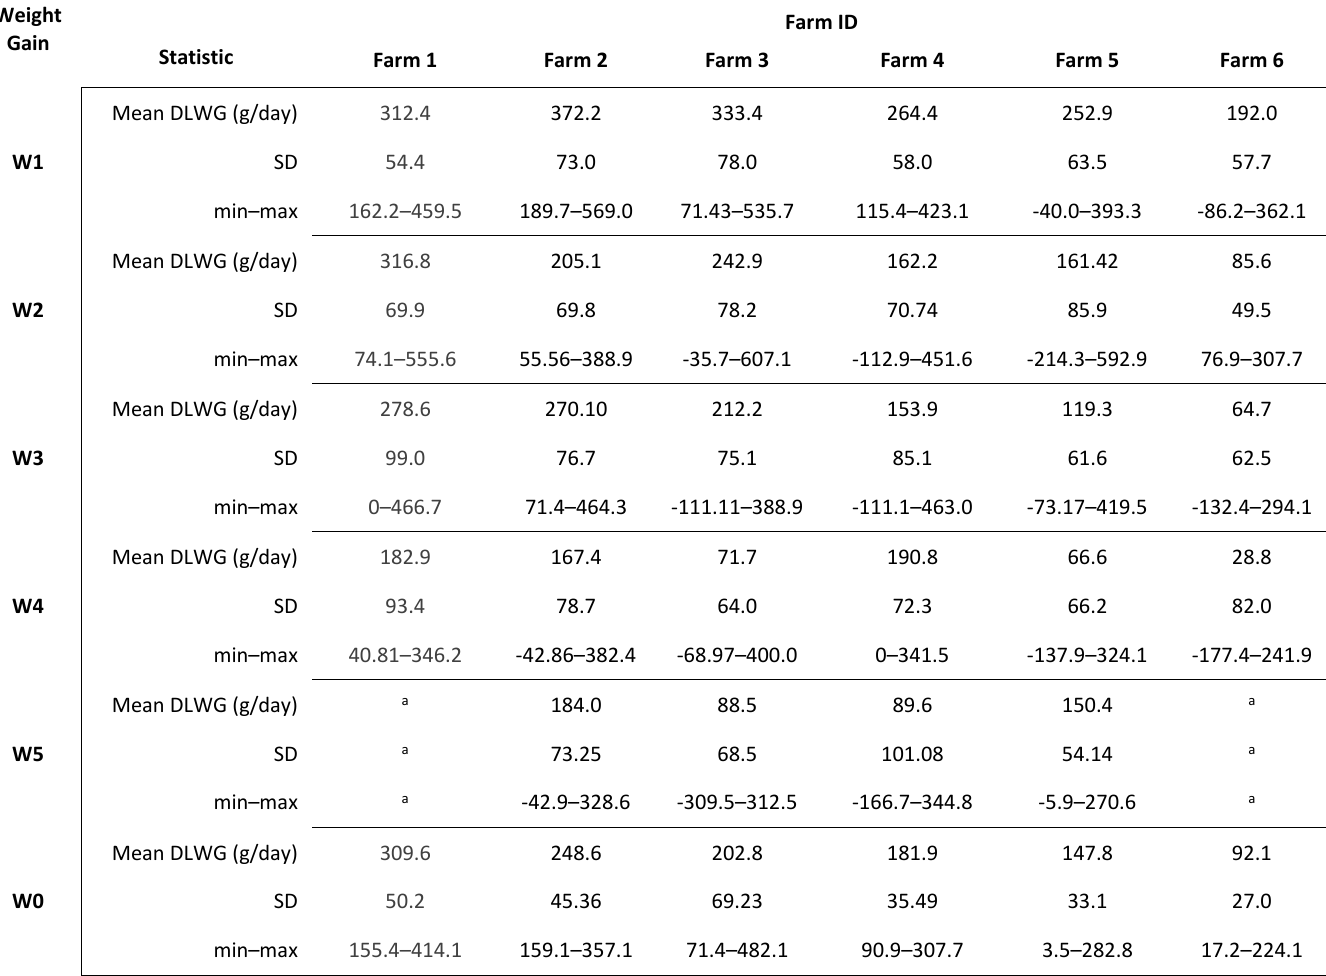
Table 6 Mean, standard deviation (SD) and range (min–max) in daily liveweight gain (DLWG) for consecutive weight gained in the time between visits 1 to 2 (W1), visits 2 to 3 (W2), visits 3 to 4 (W3), visits 4 to 5 (W5), visits 5 to 6 (W5) and overall DLWG (W0) of trial lambs on six sheep